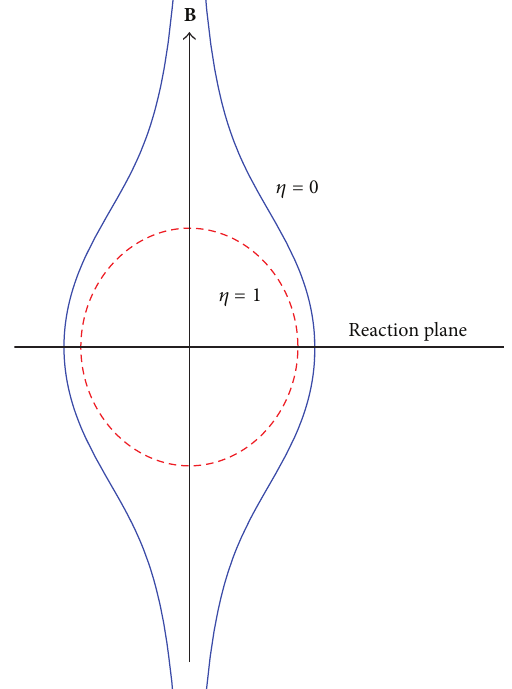
Figure 10: Azimuthal distribution of the decay rate of photons at different rapidities at LHC. Only contribution of the 𝛾 → 𝑒 + 𝑒 − channelisshown.Notethattherate 𝑤 vanishesat 𝜂 = 0 and 𝜑 = 𝜋/2 , that is, in the direction of B . However, it happens at so small values of |𝜑 − 𝜋/2| that it is beyond the experimental resolution and is not shown in the